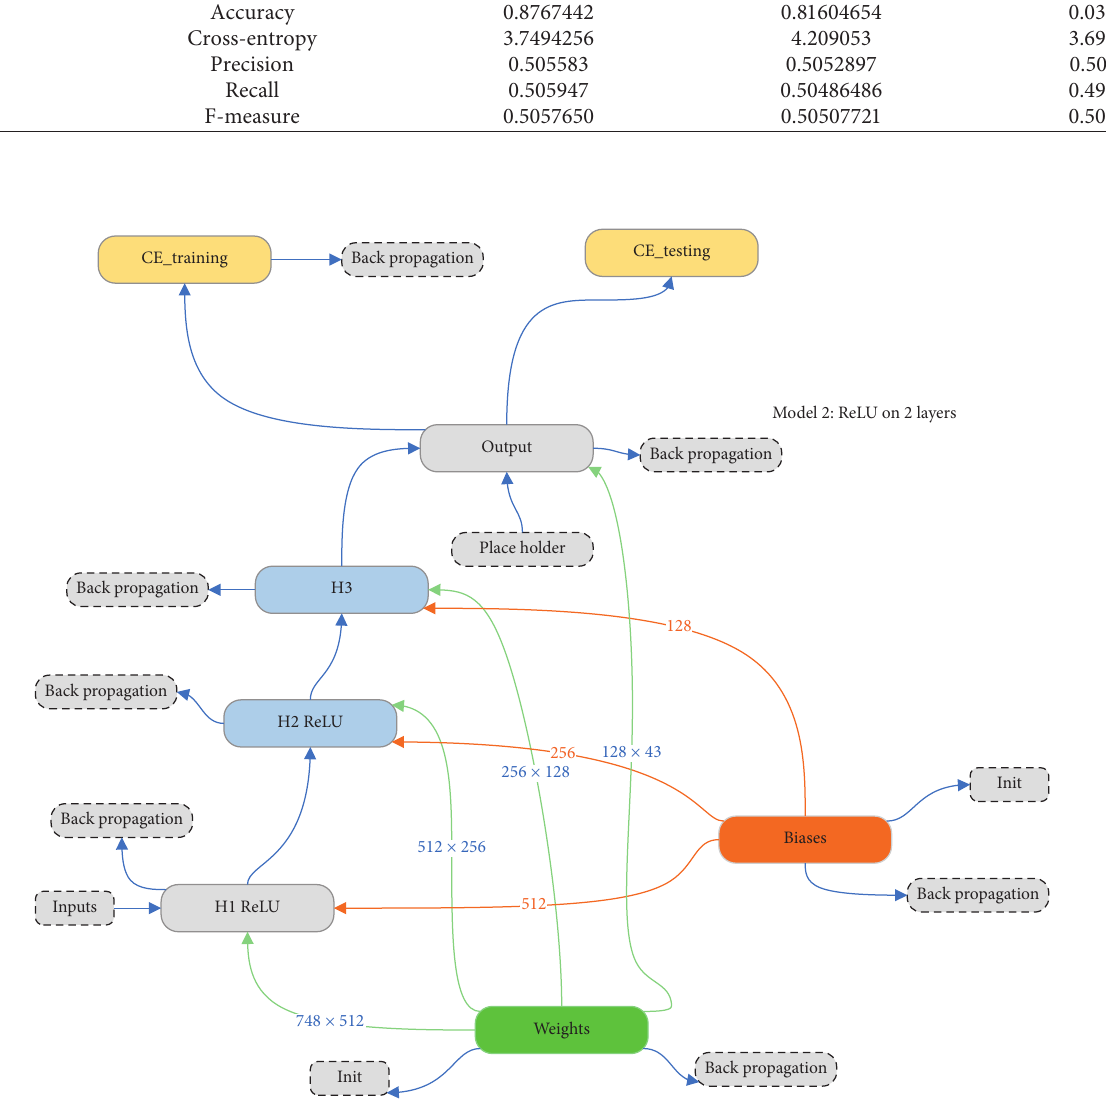
Figure 13: Architecture of the proposed Model